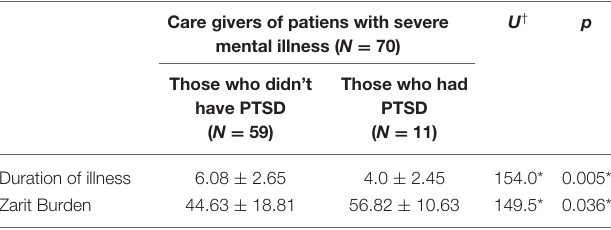
TABLE 5 | Duration of illness and Zarit Burden in caregivers of patients with severe mental illness with or without a PTSD diagnosis. U † Care givers of patiens with severe mental illness ( N = 70)